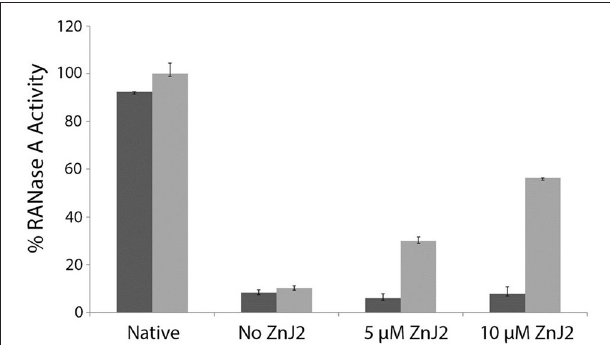
FIGURE 4 | ZnJ2 cannot promote refolding of reduced-denatured RNaseA in an anaerobic environment. RNaseA was reduced and denatured as described in Figure 2 . Refolding of reduced and denatured RNaseA was initiated by its dilution (200-fold) into renaturation buffer to a final concentration of 50 µ g/mL. Refolding was either spontaneous (marked as No ZnJ2) or performed in the presence of 5 µ M ZnJ2 or 10 µ M ZnJ2 in the presence (light gray bars) or absence (dark gray bars) of air oxygen. Aliquots were removed after 80h and transferred into the assay mixture. RNaseA activity was measured by monitoring the hydrolysis of cytidine 2 ′ :3 ′ -cyclic monophosphate at 284nm. The percentage of refolding was calculated relative to native RNaseA activity (Native). Bars represent standard deviations of three readings in the assay. The experiment was repeated twice, and similar results were